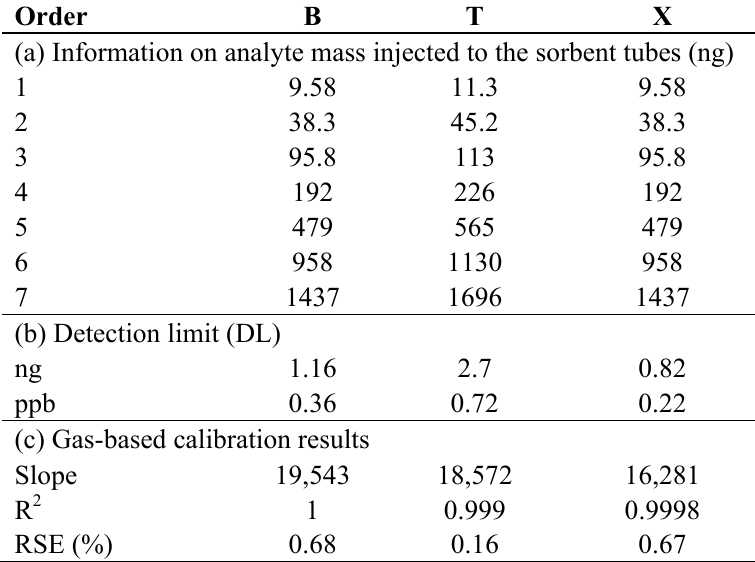
Table 3. Gas-based BTX calibration on the TD GC-FID